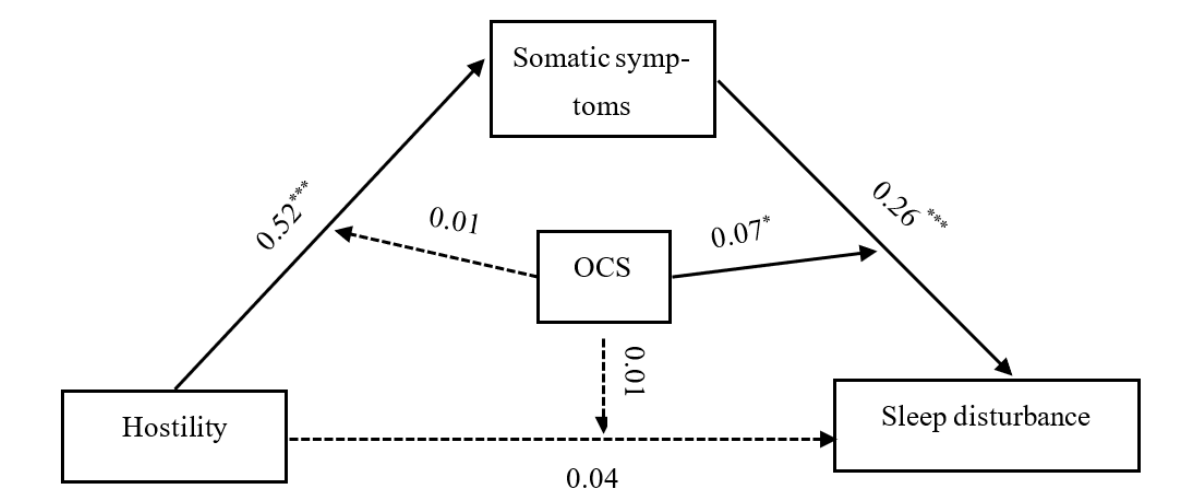
Figure 2. Diagram of the moderated mediation model. Note: Significant pathways are represented by solid arrows, and nonsignificant pathways are represented by dotted lines. Note: * means p < 0.05; *** means p <0.001.